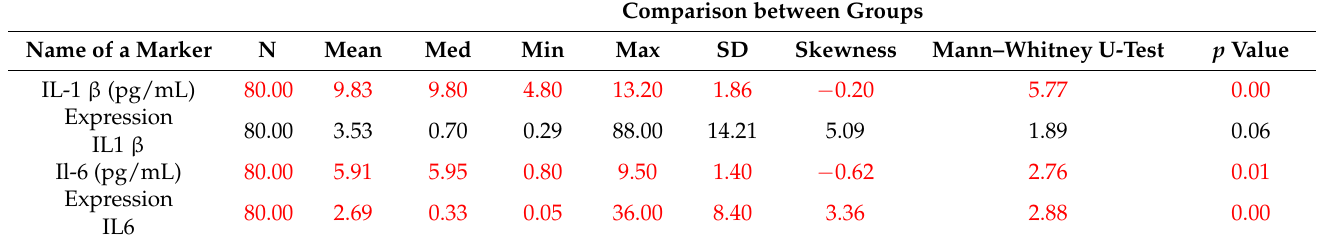
Table 4. Inflammatory markers—comparison between groups (statistically significant results marked with red colour).